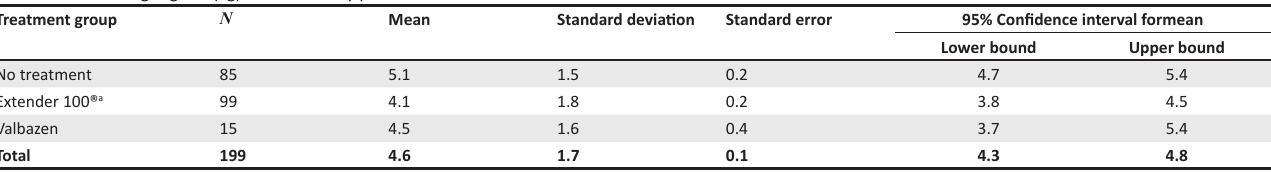
TABLE 4: Mean weight gains (kg) over the study period. Treatment